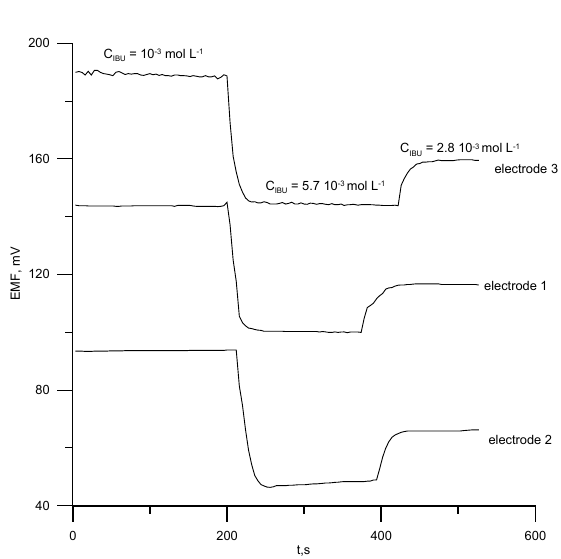
Figure 3. The response time of the ibuprofen electrodes (no. 1,2,3). Figure 4. Effect of pH on the potential of the ibuprofen electrodes